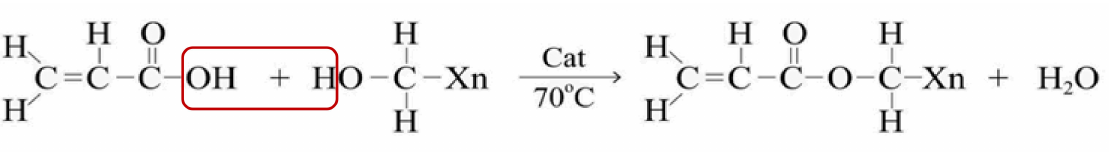
Scheme 1. Chemical polymer